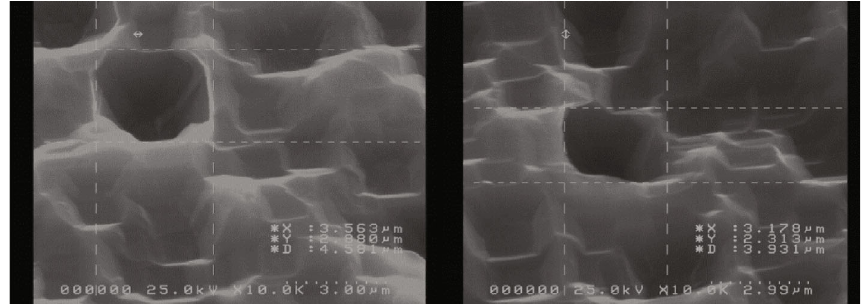
Figure 2: Surface morphologies measured at two positions of the wafer used for PERC cell fabrication in the study.